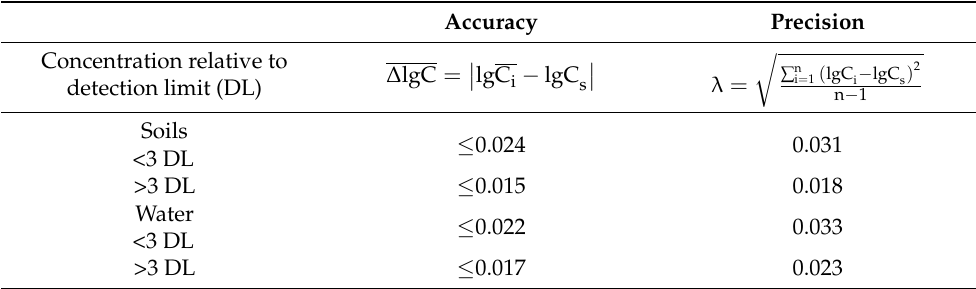
Table 1. References for accuracy and precision for routine analysis.